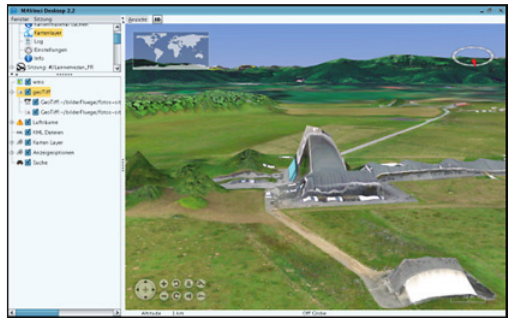
Fig. 9. Orthographic image after post-processing (Images … 2011) From the photos taken, the software can automatic- ally create a three-dimensional model of the area covered (Fig. 10).